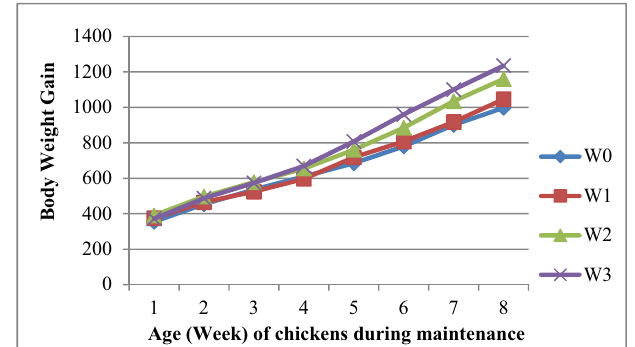
Figure 3: Body weight gain of native chicken during 8